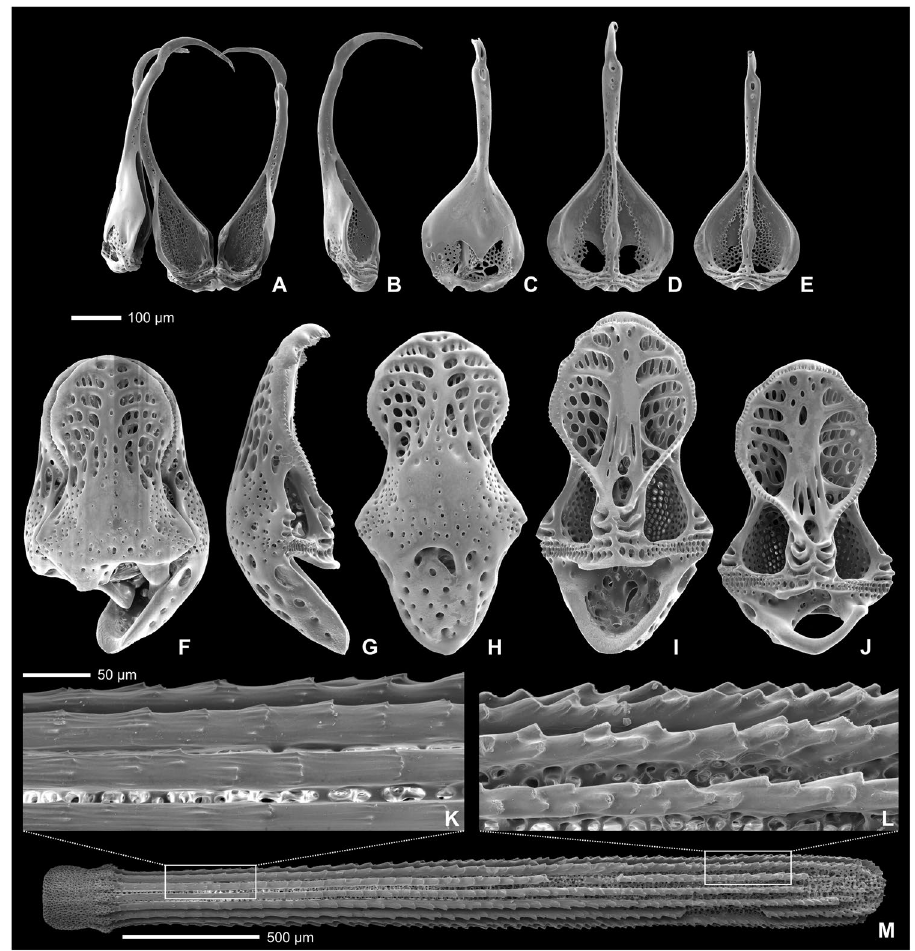
Figure 2. External appendages of Tripneustes kermadecensis n. sp. Globiferous ( A – E ) and ophicephalous ( F – J ) pedicellariae in lateral ( B , G ), external ( C , H ), and internal views ( D , E , I , J ); ( K – M ): secondary spine with details of surface sculpture close to base ( K ) and close to tip ( L ). All from paratype NHMW-Geo 2017/0016/0001; ( A , E – H , J ) derive from the aboral side of the animal, ( B – D , I , K – M ) from the oral